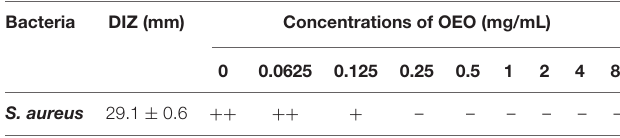
TABLE 2 | Diameter of the inhibition zone (DIZ), minimum inhibitory concentration (MIC), and minimum bactericidal concentration (MBC) of OEO against S. aureus. Bacteria DIZ (mm)